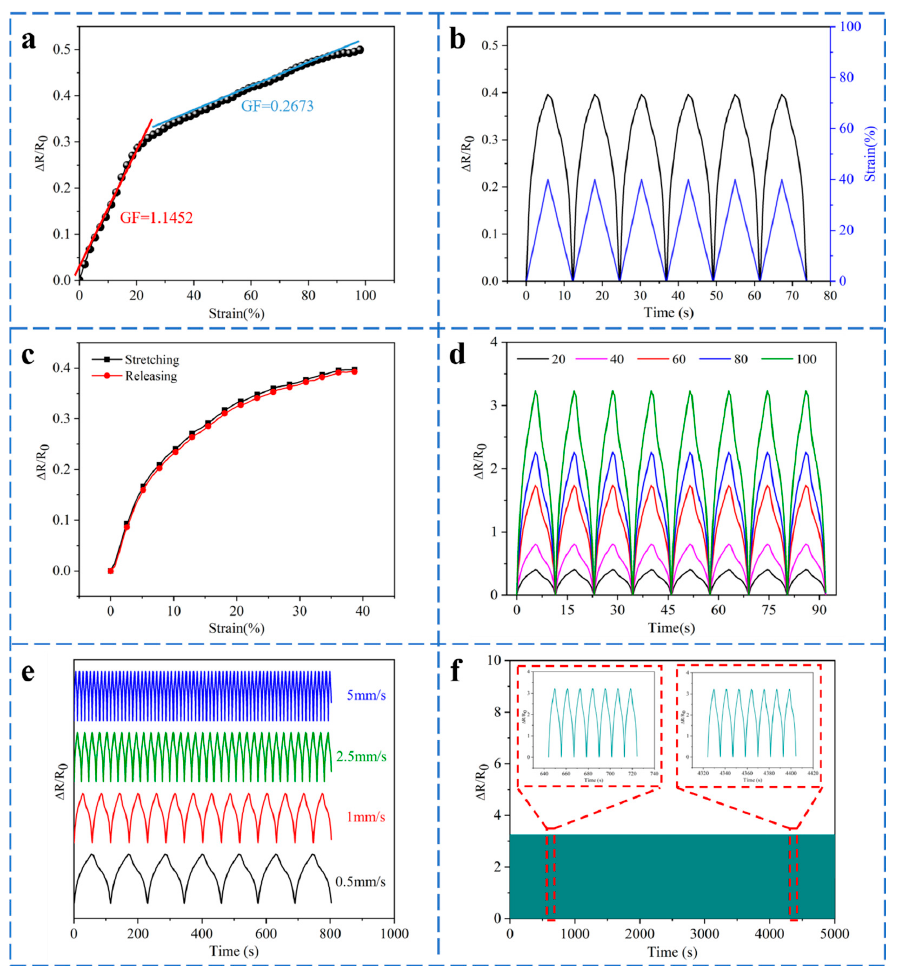
Figure 6. Sensing performance of the knitted strain sensor, ( a ) the ∆ R / R 0 curve of the sensor with strain, ( b ) the curves of ∆ R / R 0 and strain varying with time, ( c ) single stretching–releasing curve of the sensor, ( d ) the curves of ∆ R / R 0 under different strains (0–100%), ( e ) ∆ R / R 0 of strain sensor under different stretching rates of 40% strain, ( f ) the stretching–releasing tests under a cyclic strain of